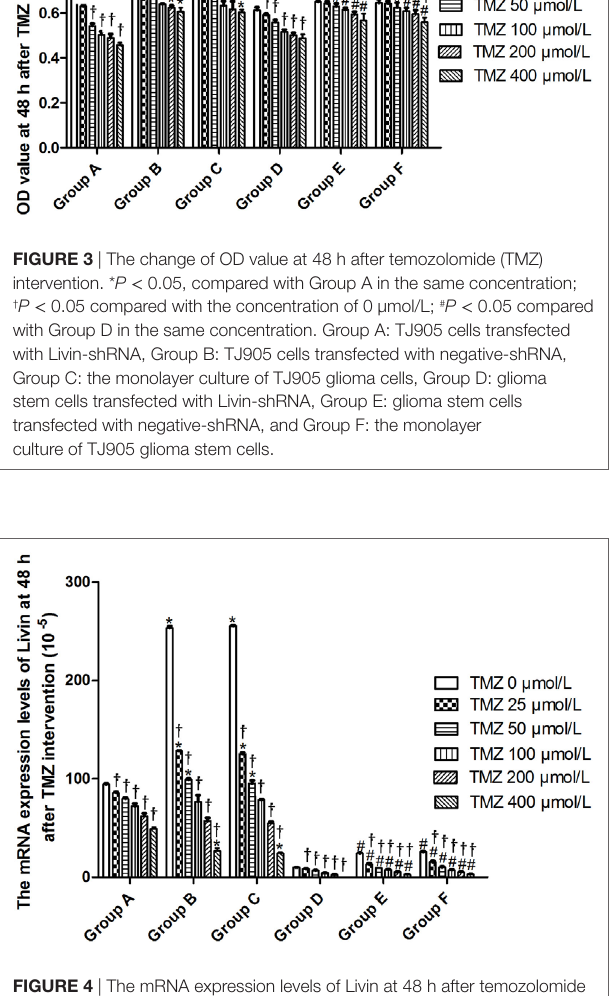
FigUre 4 | The mRNA expression levels of Livin at 48 h after temozolomide (TMZ) intervention (10 − 5 ). * P < 0.05, compared with Group A in the same concentration; † P < 0.05 compared with the concentration of 0 µmol/L; # P < 0.05 compared with Group D in the same concentration. Group A: TJ905 cells transfected with Livin-shRNA, Group B: TJ905 cells transfected with negative-shRNA, Group C: the monolayer culture of TJ905 glioma cells, Group D: glioma stem cells transfected with Livin-shRNA, Group E: glioma stem cells transfected with negative-shRNA, and Group F: the monolayer culture of TJ905 glioma stem cells.